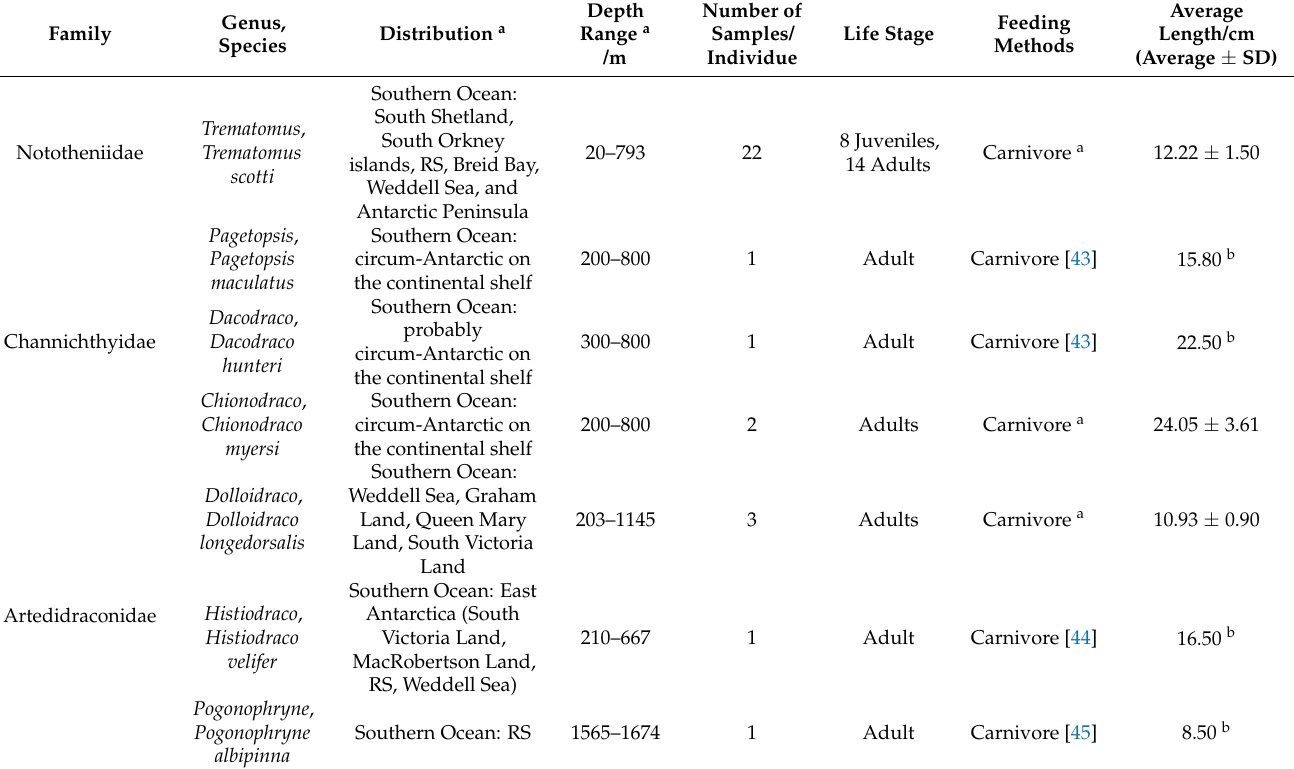
Table 2. The biological characteristics of the collected 10 species of fish in 5